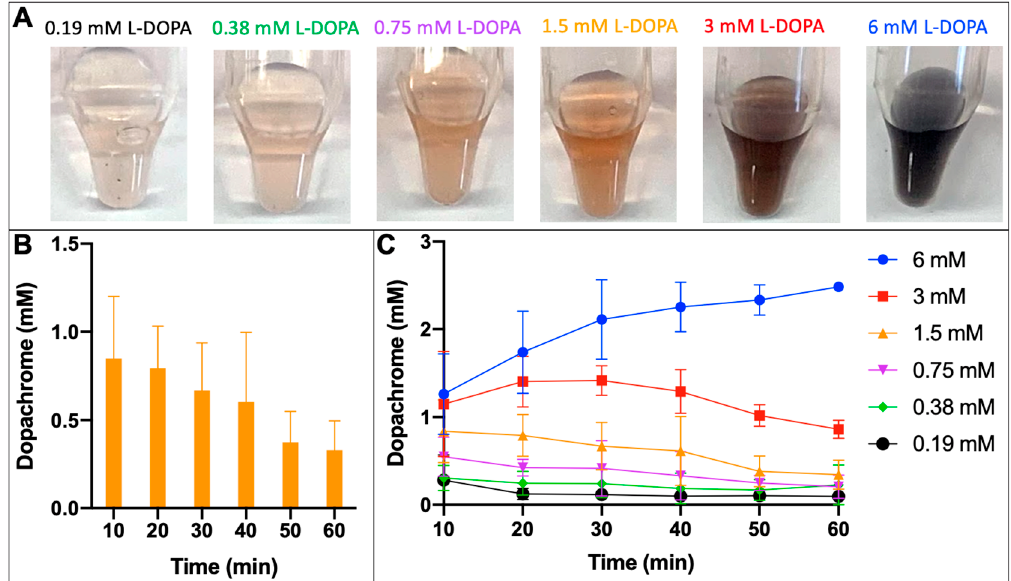
Figure 4. Isolated native dopachrome products of TYR-MB reaction. ( A ) The increasing concentrations of L-DOPA (left to right) show a change in color from clear through orange to black at 10 min of incubation. ( B ) When using 1.5 mM L-DOPA, the production of dopachrome peaks at 10 min and then declines. ( C ) The concentration of dopachrome increases as the concentration of L-DOPA increases from 0.19–6 mM.